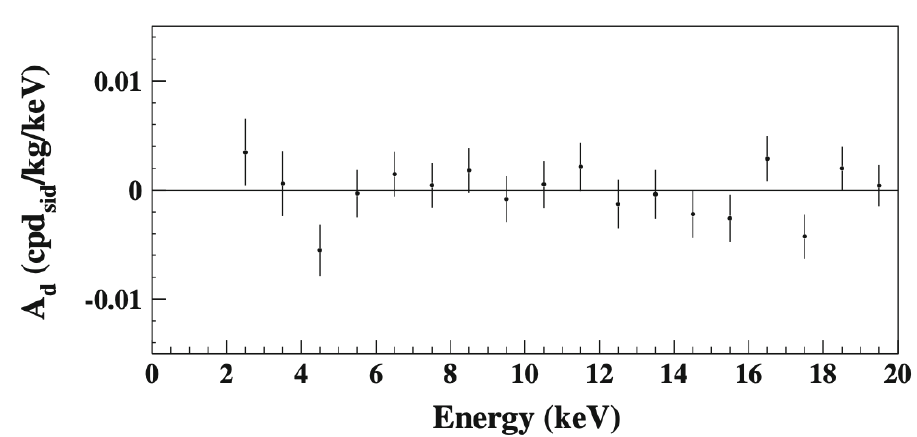
Figure 4. Diurnal modulation amplitudes, A d , as function of energy (the energy bin is 1 keV) obtained by fitting the single-hit residual rate of the first four annual cycles of DAMA/LIBRA–phase1 (exposure of 1.04 tons × year) as function of the sidereal time, with the formula A d cos [ ω rot ( t − t d )] . The amplitude A d is a free parameter, while the period is fixed at 24 h and the phase at 14 h, as expected for the dark matter diurnal modulation effect. The A d values are compatible with zero, having random fluctuations around zero with χ 2 equal to 19.5 for 18 degrees of freedom. Reprinted from Ref. [31] with Copyright Permission from The European Physical Journal